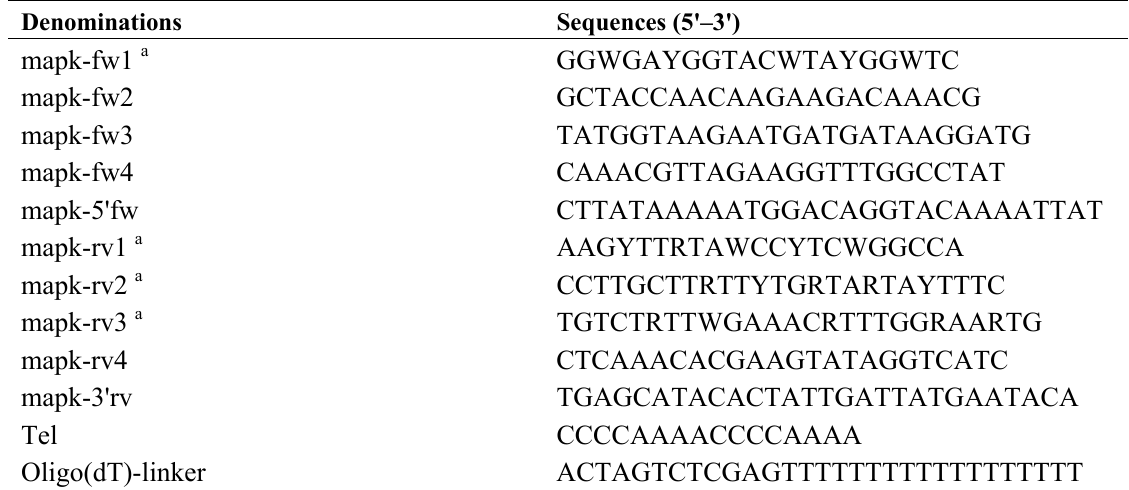
Table 1. Polymerase Chain Reactions (PCR)